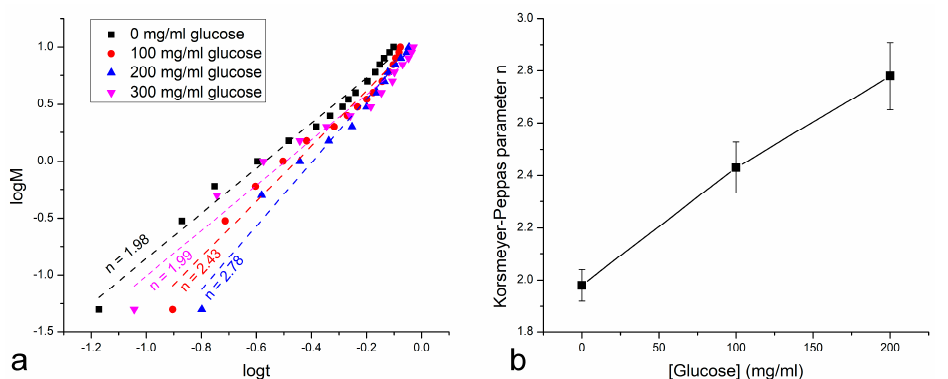
Figure 4 Figure 4. Comparative insulin proxy release profiles for MnO 2 @PCL films at different glucose concentrations in the medium ( a ) and the projected release after 1 h, 24 h, 7 days and 10 days at different glucose concentrations ( b ). Data points are shown as averages (n = 3), while error bars represent standard deviations. Statistically significantly ( p < 0.05) different expressions between the Materials 2023 , 16 , x FOR PEER REVIEW sample groups are marked with asterisks.